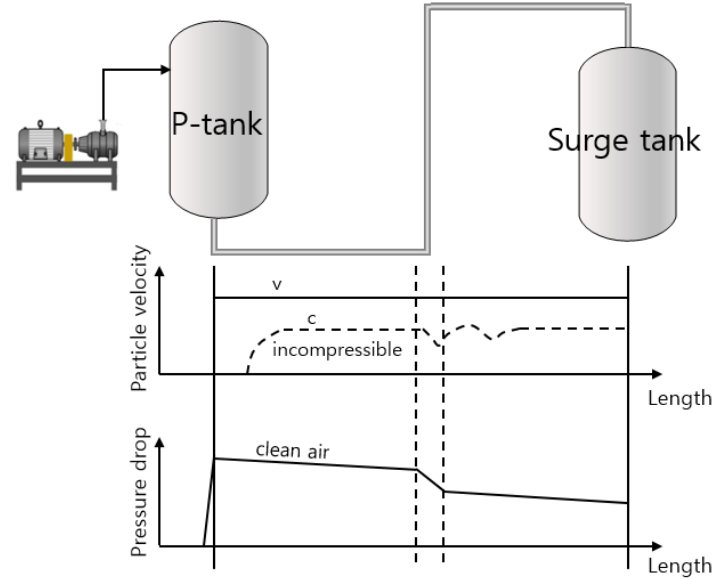
Figure 3. Conceptual diagram and pressure loss configuration of BTS.